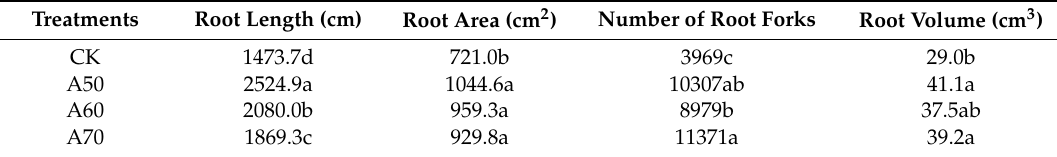
Table 2. Root growth characteristics in MP.